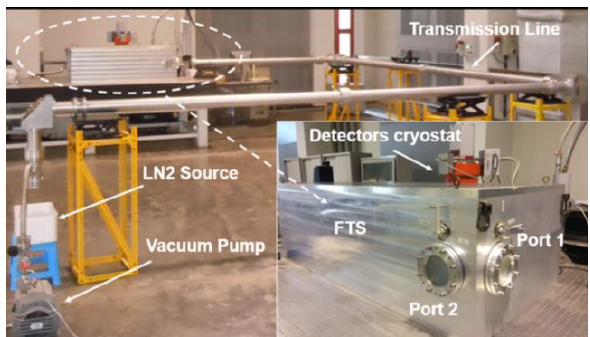
Fig.2: Experimental set-up for TL attenuation measurement